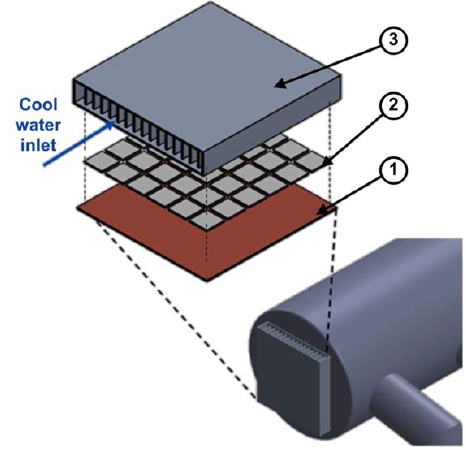
Figure 5. Exploded view of TEG device.